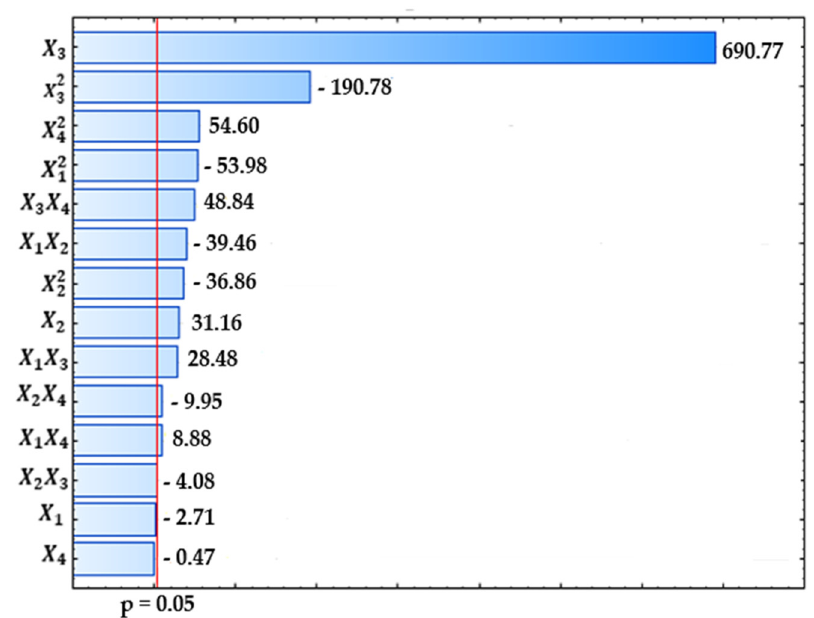
enzymatic esterification of the babassu free fatty acids. (X 1 ) temperature (°C), (X 2 ) time (hours), (X 3 ) molar ratio (FFAs: alcohol), (X 4 ) biocatalyst content (% m/m).